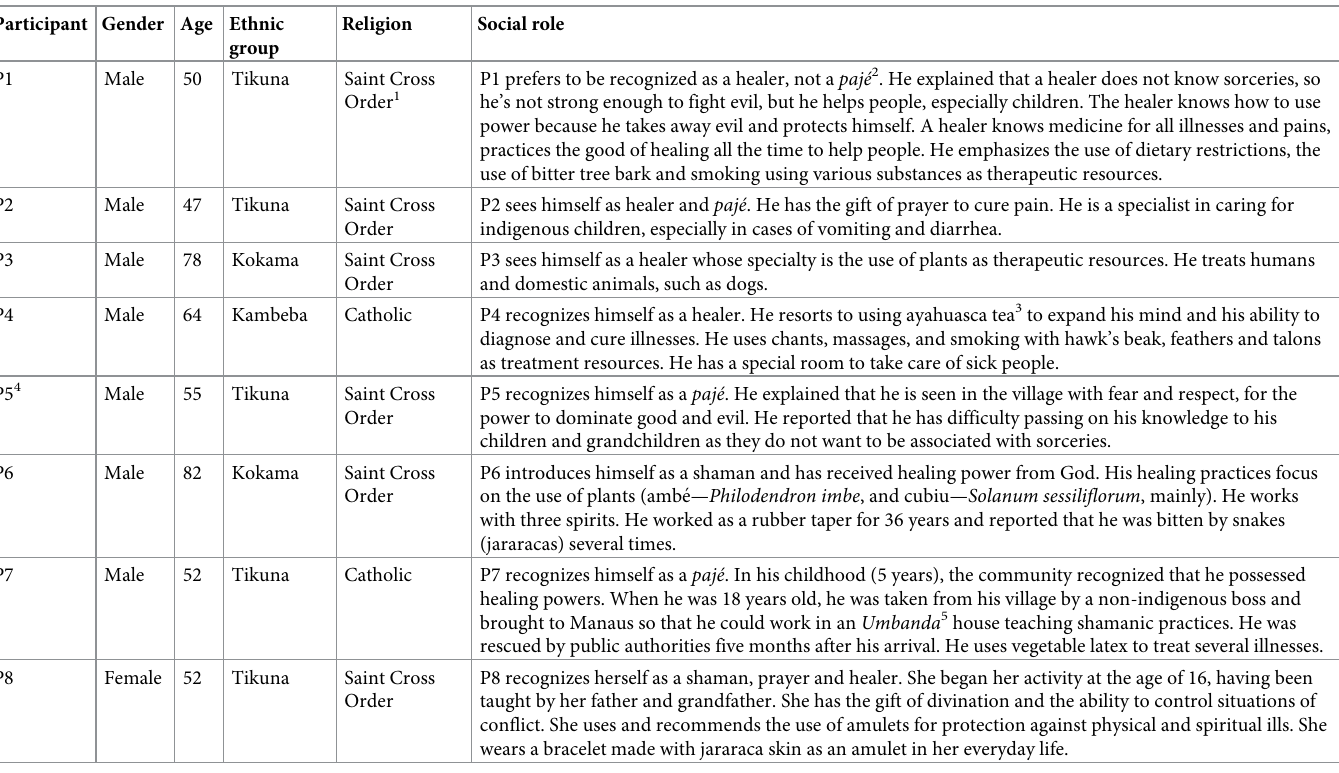
Table 2. Characteristics of the